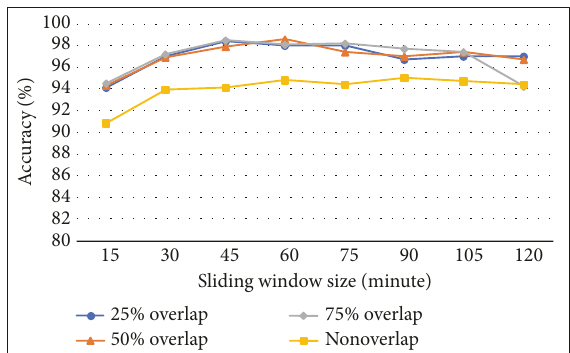
Figure 13: Plot of the accuracy across sliding window size and overlapping